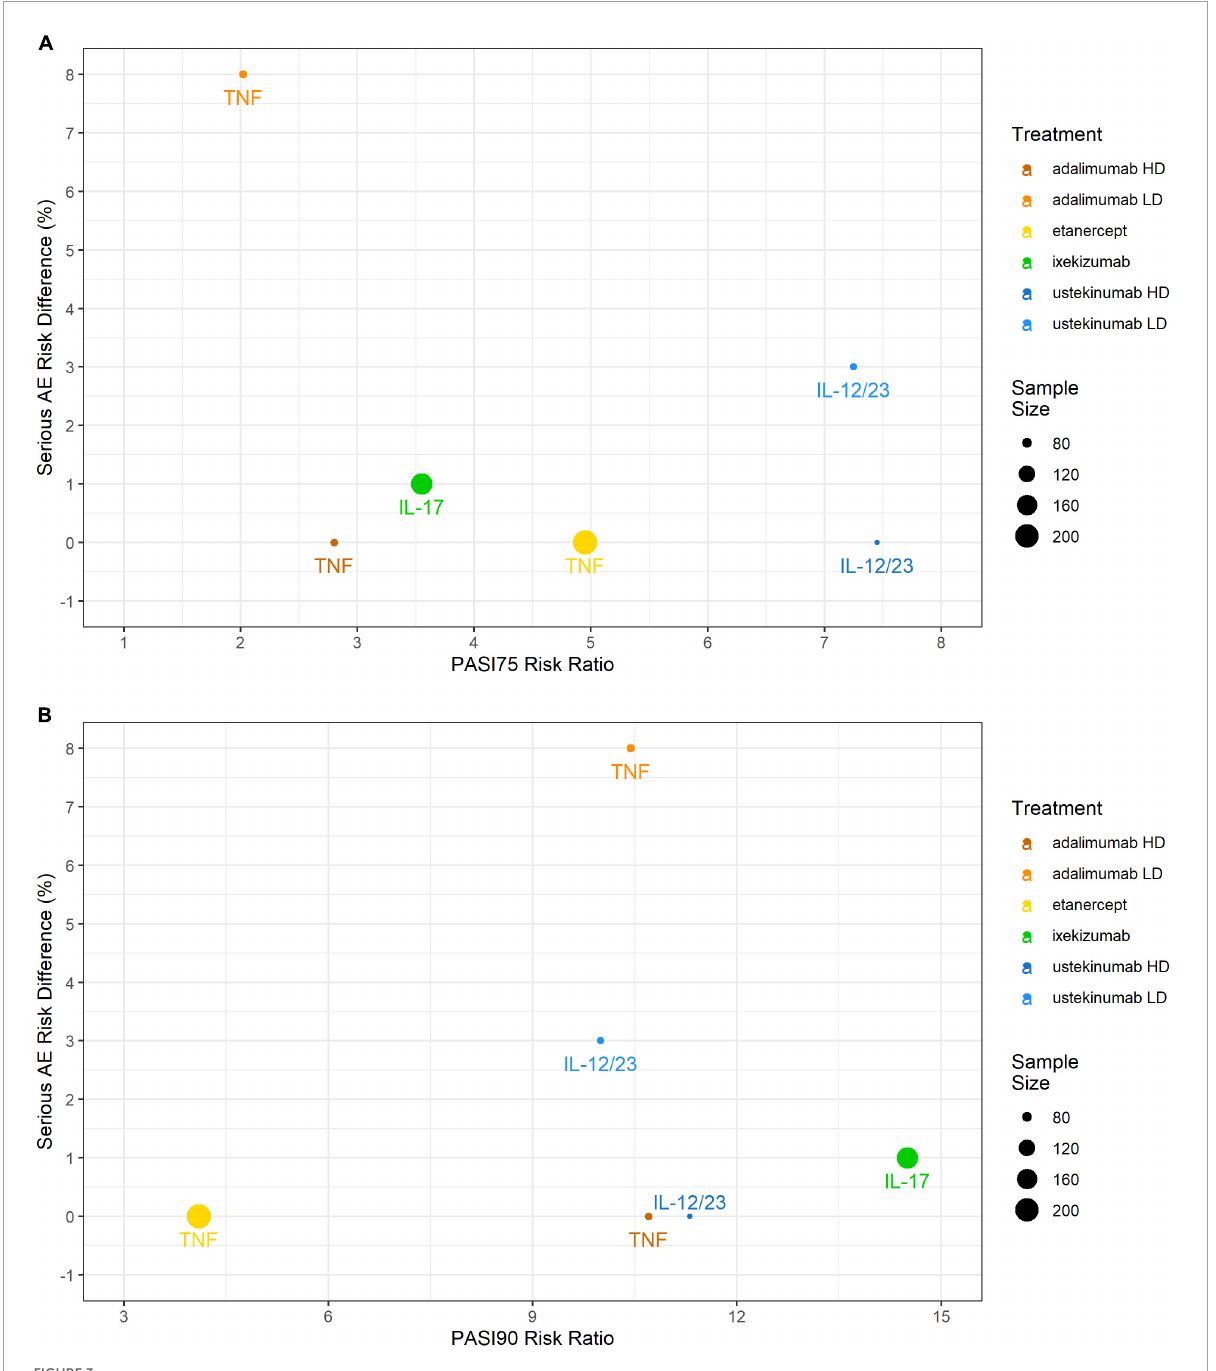
FIGURE3 Comparing efficacy (PASI75 and PASI90 RRs) against safety (RD) in the pediatric psoriasis RCTs that reported both outcomes. (A) PASI75 RR versus SAEs RD; (B) PASI90 RR versus SAEs RD. PASI, Psoriasis Area and Severity Index; RCT, randomized controlled trial; RD, risk difference; SAE, serious adverse